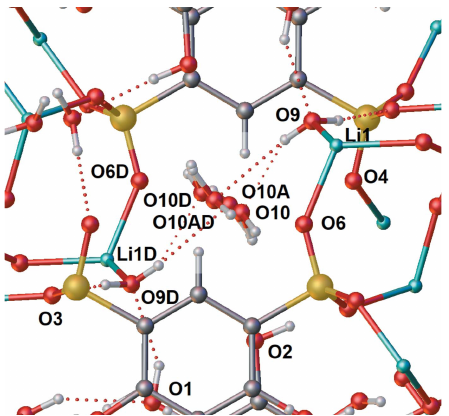
Figure 3 Ball and stick representation of Li 2 (tiron) (cid:2) 2.5H 2 O, including the H- bonding environment of neighboring tiron anions and water showing all disorder components. Atom labels with the suffix D are generated via inversion through the center of symmetry at Wyckoff position d . Atom labels with the suffix A represent minor components of two-site disorder models.